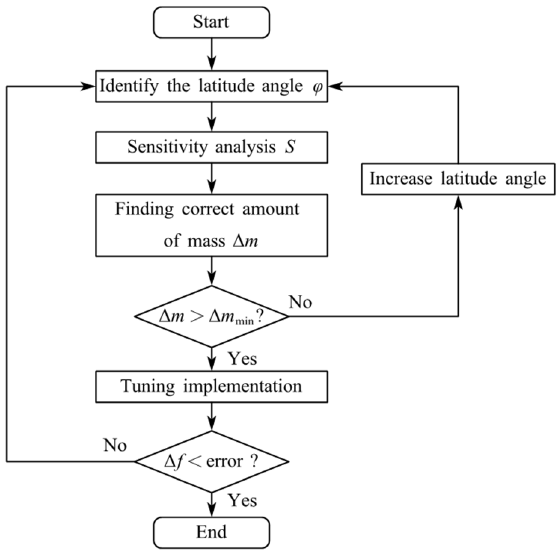
Figure 6. Flow chart of modal tuning.